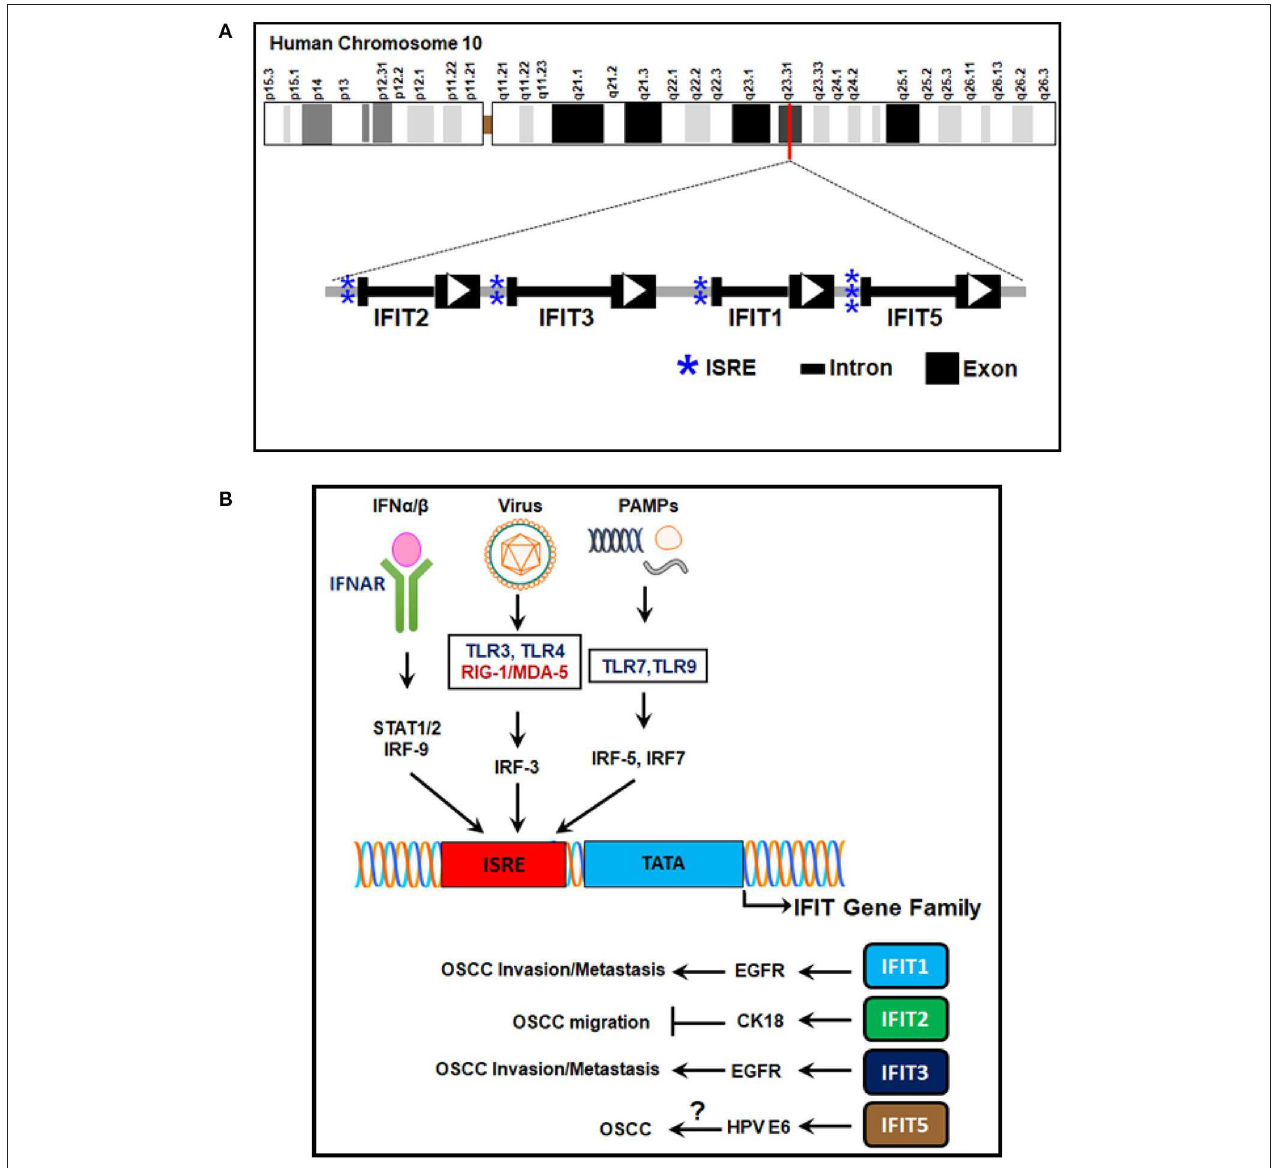
FIGURE 1 | Human IFIT gene family location, structure, and transcriptional regulation. (A) The genetic architecture of human IFITs. The human IFIT genes are located on human chromosome 10q23.31. The exons are depicted as black boxes, the introns as dark lines, and ISREs in the promoter regions as blue asterisks. The direction of the open reading frames (ORFs) is designated by white arrowheads. (B) Signaling pathways of IFIT gene transcription. The ISREs in the promoter regions of IFIT genes are induced by stimulation of cell surface receptors such as IFNAR- α / β , TLR-3, RIG-I/MDA-5, TLR-7, and TLR-9 by IFN- α / β , viral infection, and PAMPs. Transcriptional induction is mediated by various transcription factors, such as IRF-3, IRF-5, IRF-7, and IRF-9 . The encoded proteins ( IFIT1, IFIT2, IFIT3, and IFIT5 ) regulate OSCC progression. IFIT1/IFIT3 promote OSCC invasion and metastasis by EGFR activation. IFIT2 inhibits OSCC migration via CK-18 . IFIT5 expression is correlated with HPV E6 protein in OSCC. However, its mechanism in OSCC is not yet understood. IFN- α / β , interferon alpha/beta; IFNAR- α / β , interferon alpha/beta receptors; STAT1/2 , signal transducer and activator of transcription 1/2; TLRs , Toll-like receptors; RIG-I , retinoic acid-inducible gene-I; MDA-5 , melanoma differentiation-associated gene-5; IRFs , interferon regulatory factors; ISRE , interferon-stimulated responsive elements; IFIT , interferon-induced proteins with tetratricopeptide repeats; EGFR , epidermal growth factor receptor, CK-18 , cytokeratin-18; HPV E6 , human papilloma virus early protein-6; OSCC , oral squamous cell